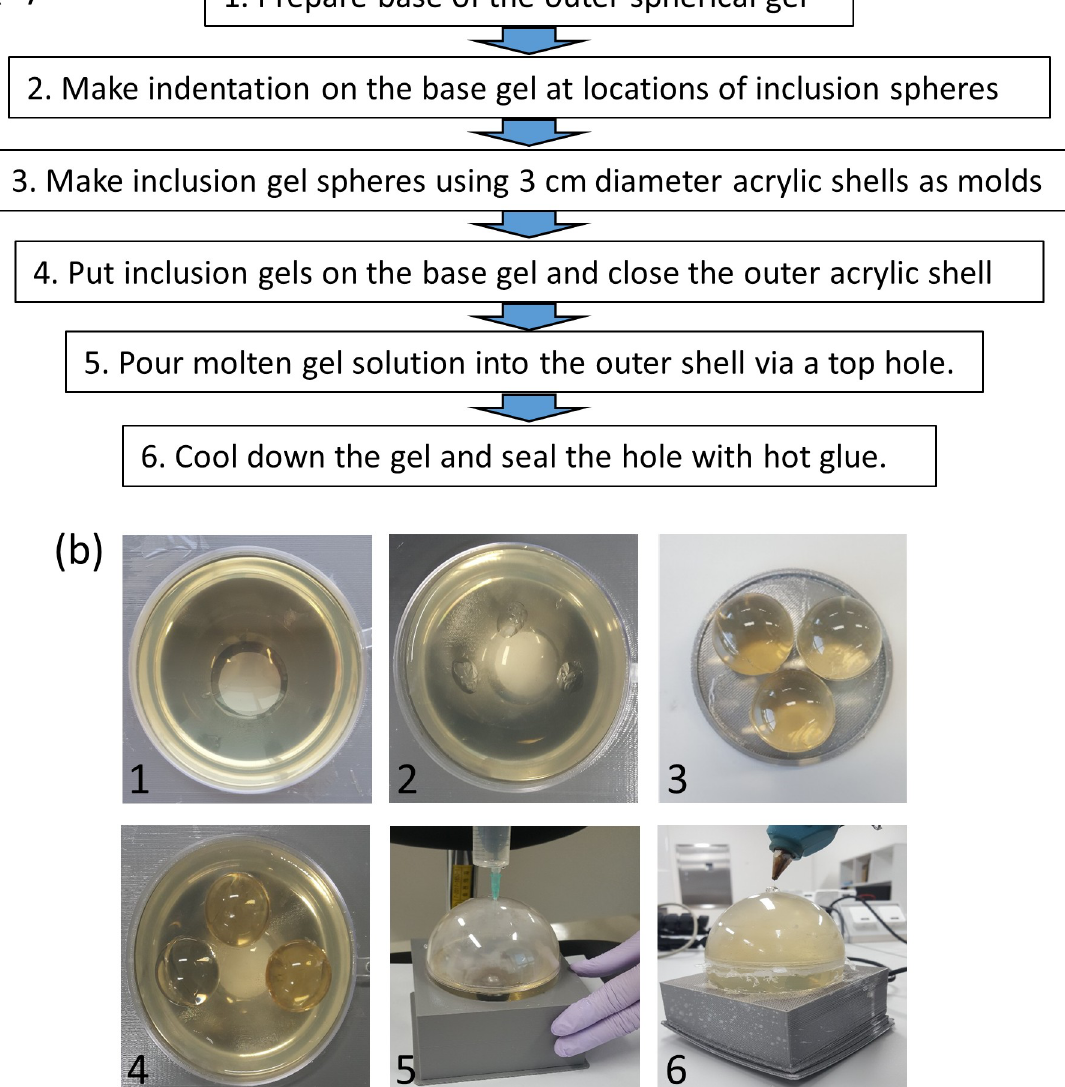
Fig 2. Fabrication workflow. (a) Steps for the fabrication of a spherical inclusion phantom. (b) Pictures of each step. 3D-printed, bowl- shaped holder (grey) had a hole in the middle which is visible in Steps 1, 2, 4.